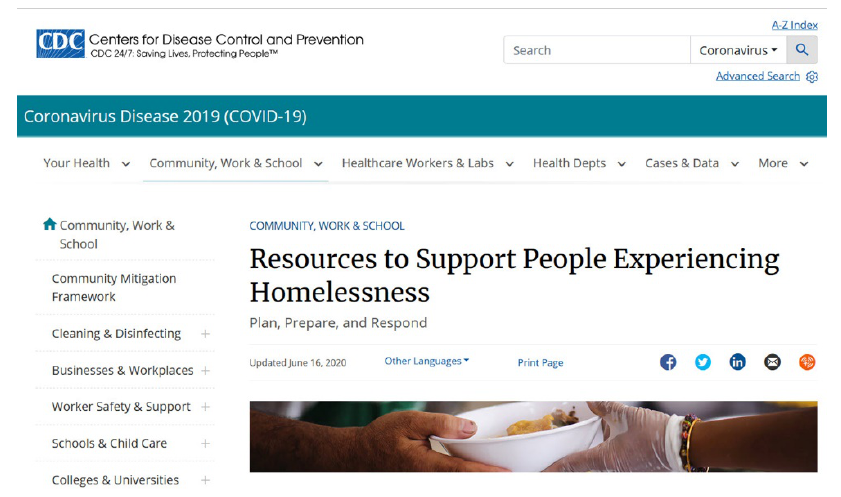
Figure 2 Screen capture of US Centers for Disease Control and Prevention: Resources to Support People Experiencing